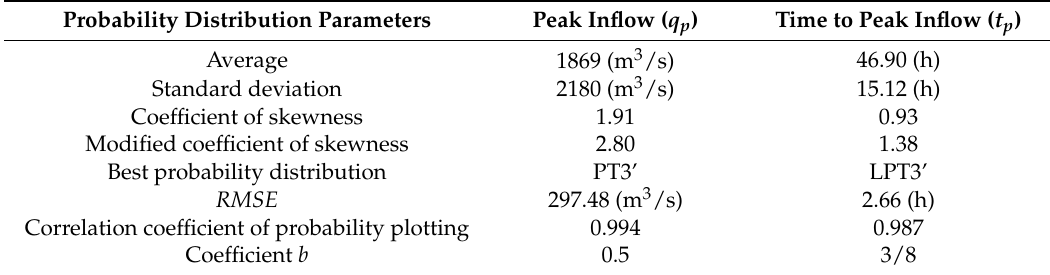
Figure 9. Probability plot of time to peak inflow ( t p ) for Shih-Men Reservoir for the log-Pearson Type III distribution. Table 2. Optimal probability distribution coefficients for the inflow hydrograph for Shih-Men Reservoir.